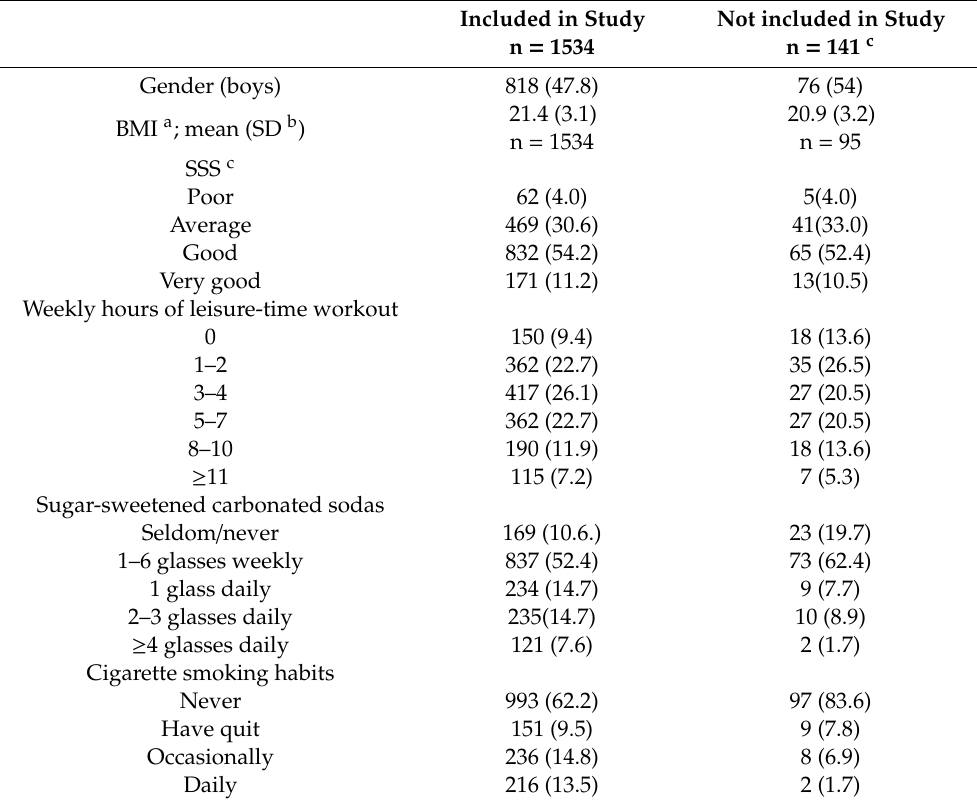
Table A3. Description of included and missing observations in the SEM for the 2017